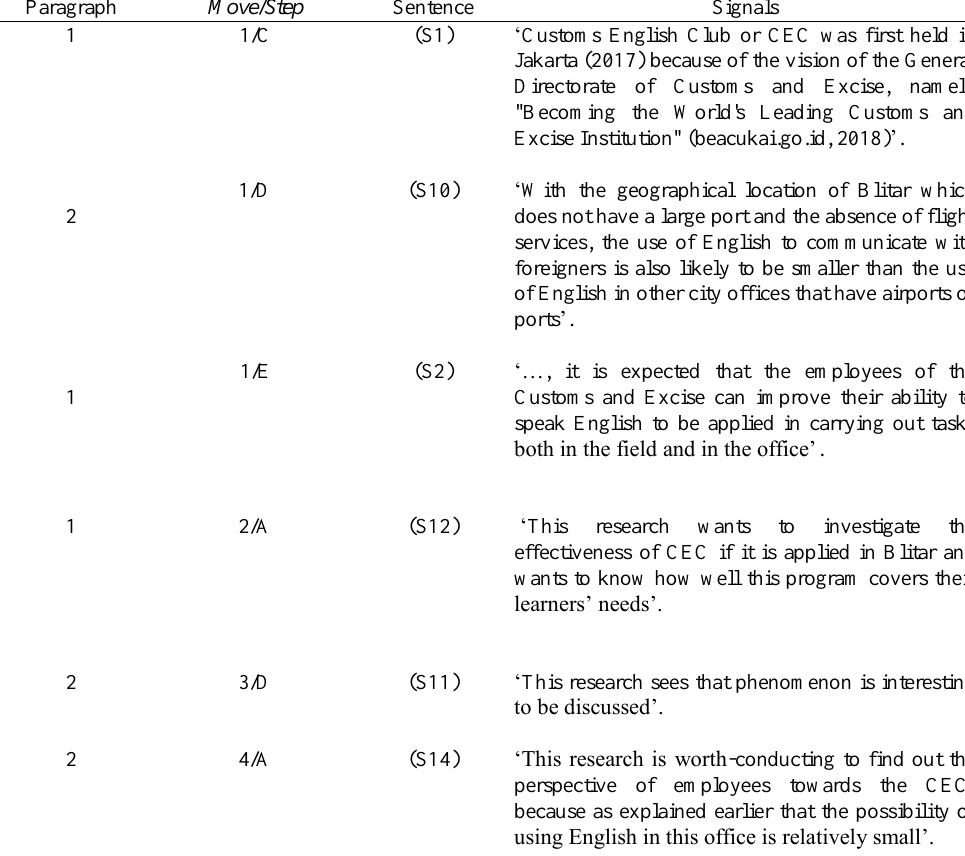
Move and Step in research article introduction in research article 3.1.